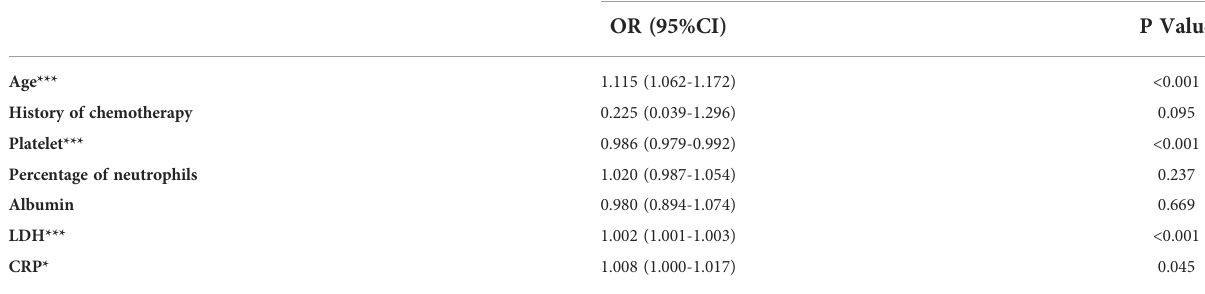
TABLE 4 Multivariate Logistic regression analysis of predictors of outcomes.